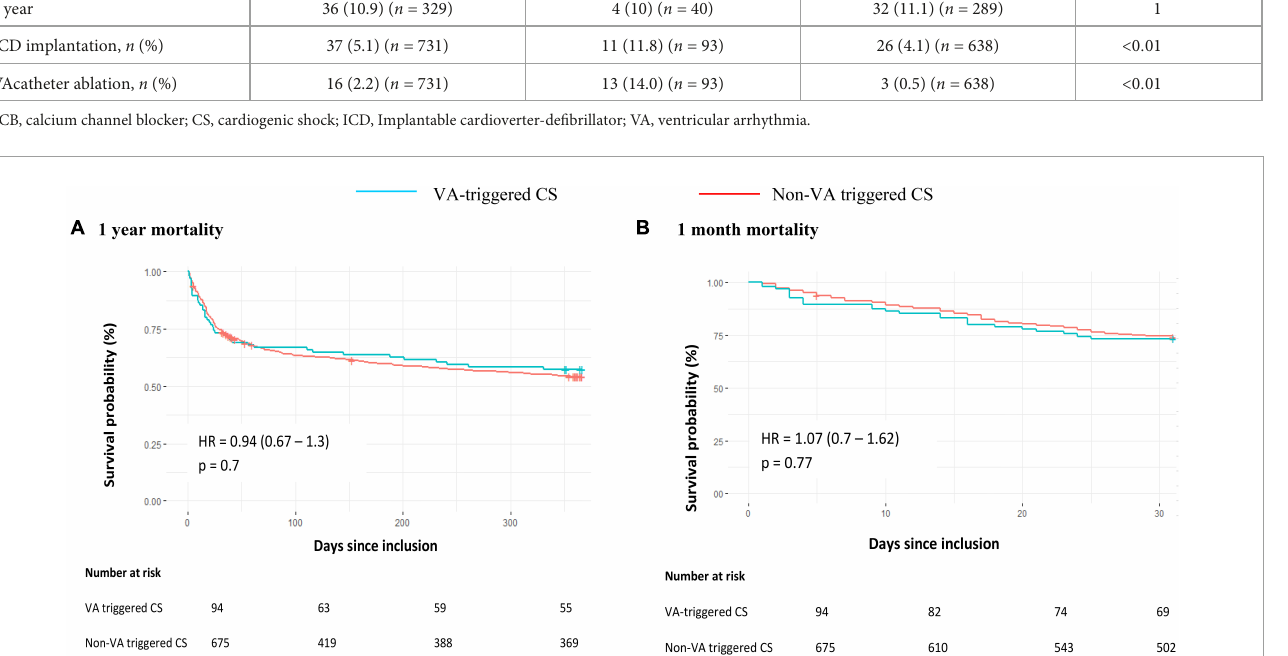
VA-triggered CS Non-VA triggered CS ( n = 94) ( n = 675)